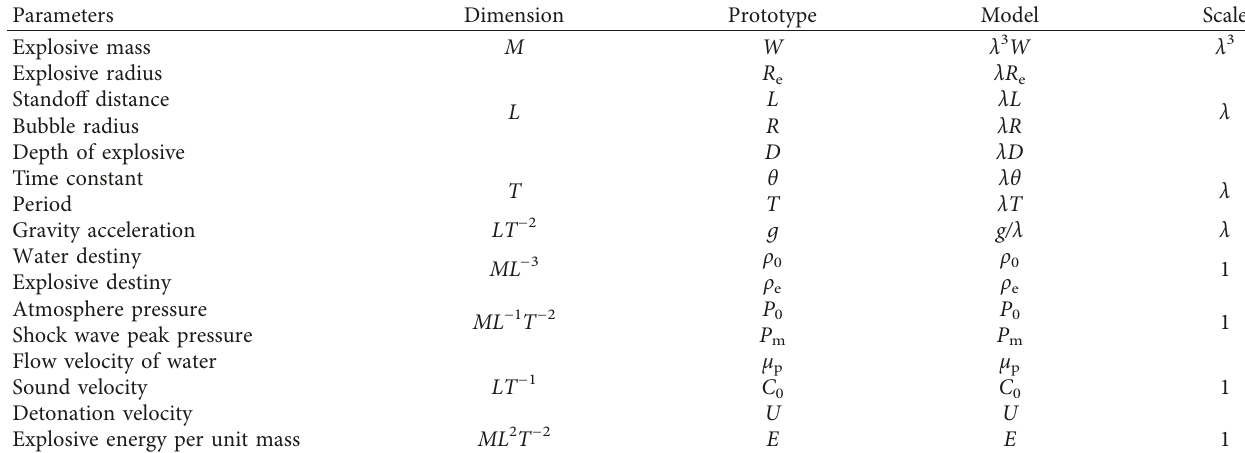
Table 2: The centrifugal similarity relation.